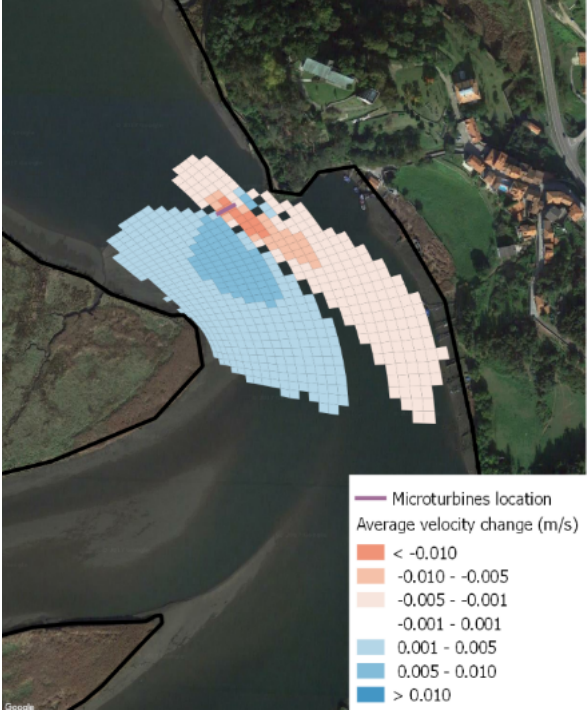
Figure 7: Average velocity change